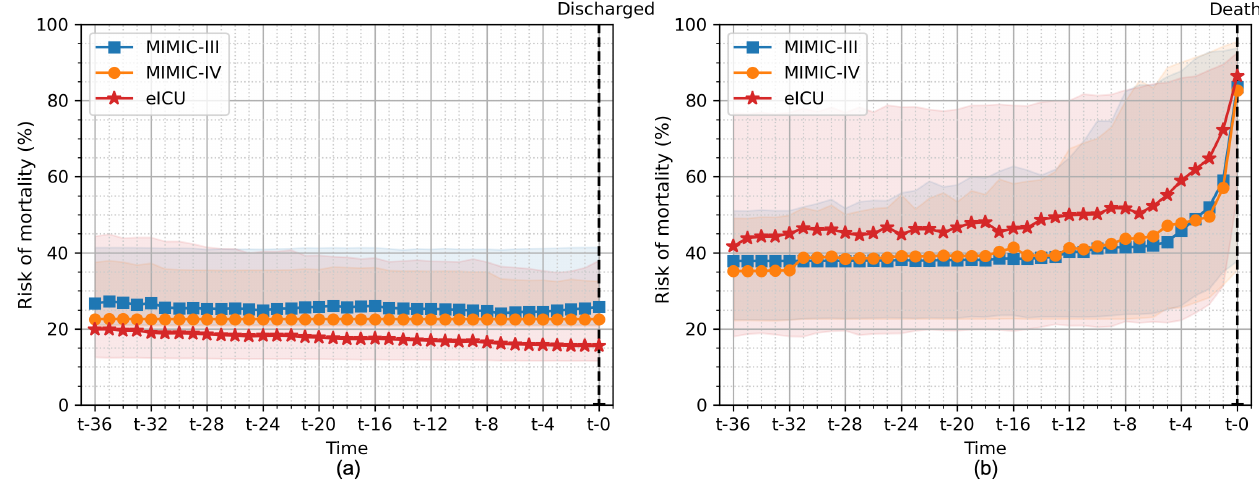
Figure 9. The risk of mortality calculated for all patients in the hold-out test set for ( a ) those patients who survived their ICU stay and ( b ) those patients who subsequently died during their ICU stay. The line plots show the median, and the shaded areas show the 25th and 75th quartiles of risk of mortality bootstrapped from all cross-validation folds. Among the surviving patients, the risk of mortality was low and tended to decrease until discharge. In contrast, among patients who died during their stay, the risk of mortality was high and increased until the patient’s death. A sharp increase in the risk of mortality was observed eight hours before